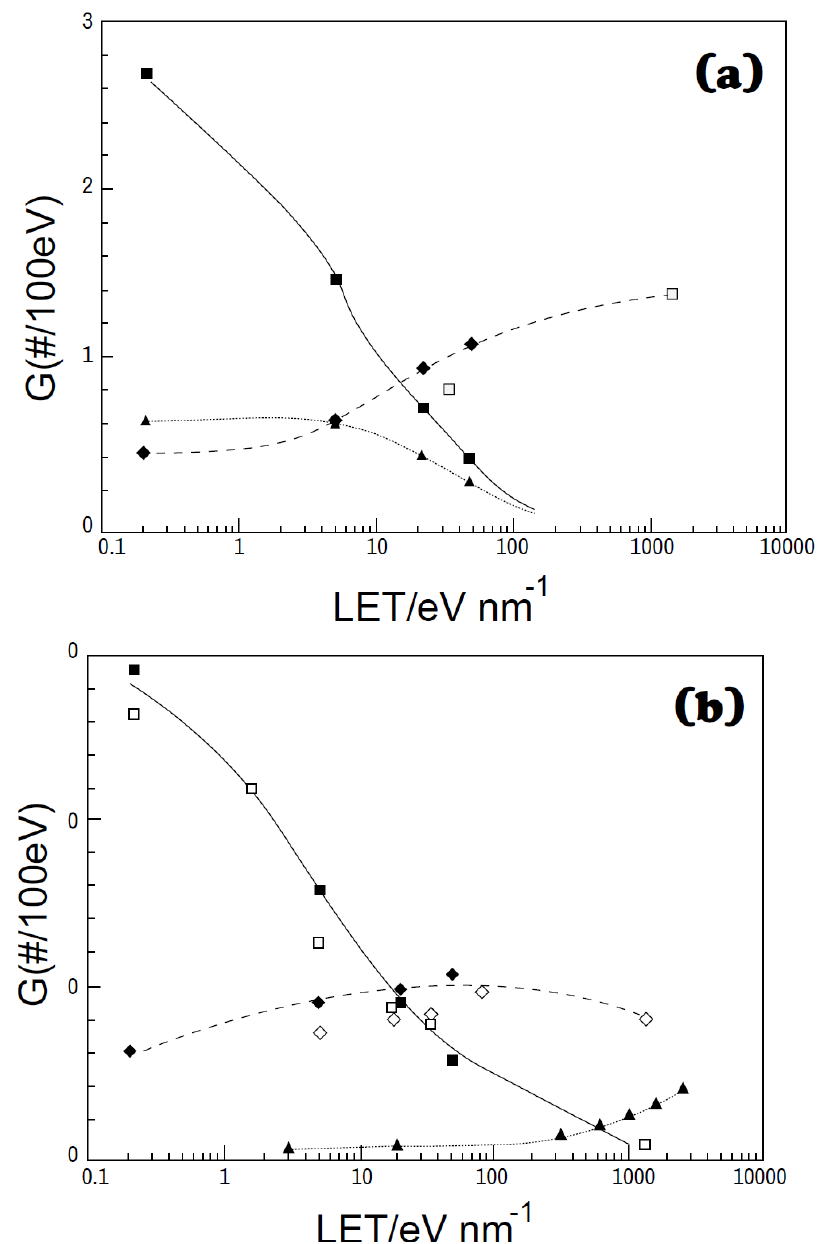
Figure 28. ( a ) G-values for e − aq (filled squares), H (filled triangles) and H 2 (filled and open diamonds) as a function of LET. ( b ) G-values for OH (filled and open squares, H 2 O 2 (filled and open diamonds) and HO 2 (filled triangle) (filled squares), as a function of LET (data from Elliot and McCracken [53]). In each block, the following parameters are characterized: cross section area, A (m 2 ); length, L (m); water volume, V (m 3 ); coolant mass flow rate, U (kg/s); average